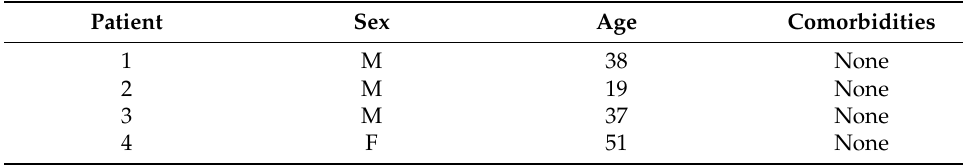
Table 1. Demographic characteristics of patients included in the